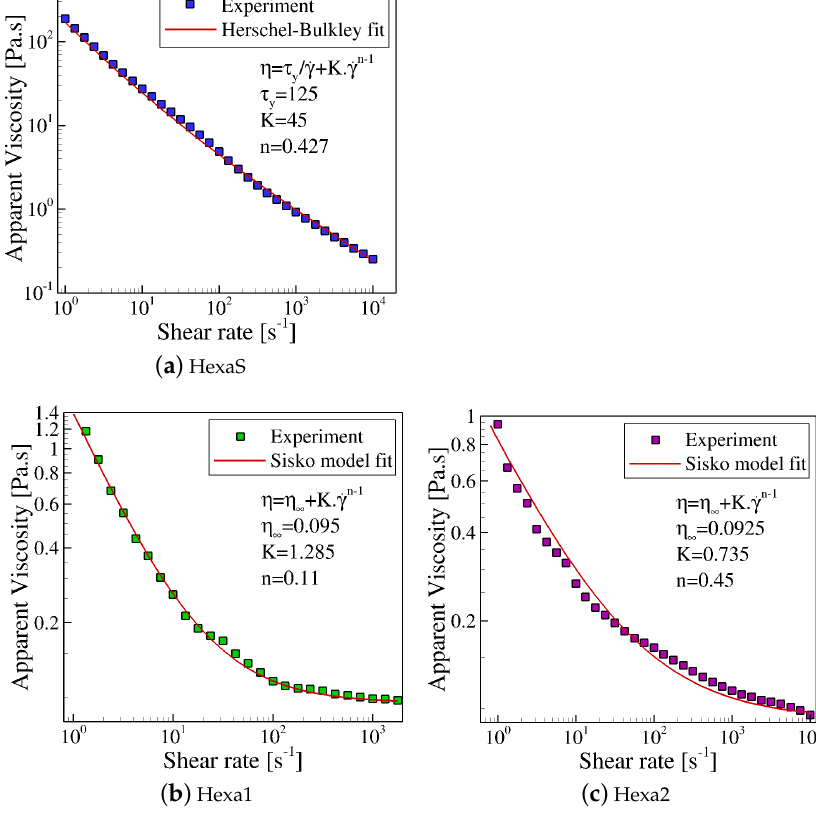
Figure 3. Graphene ink viscosity curves fitted with the GNF models: ( a ) HexaS fitted with the Herschel-Bulkley model; ( b ) Hexa-1 and ( c ) Hexa-2 fitted with the Sisko